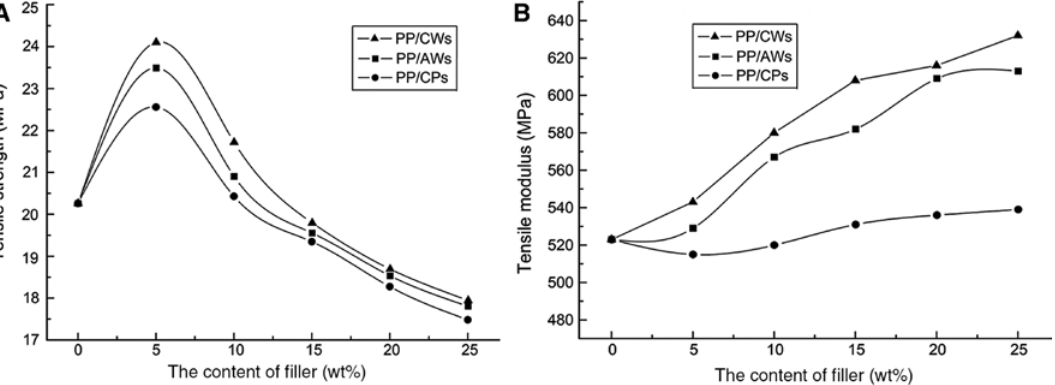
Figure 2: The results of tensile properties for PP/CWs, PP/AWs, and PP/CPs composites: (A) tensile strength, (B) tensile modulus.